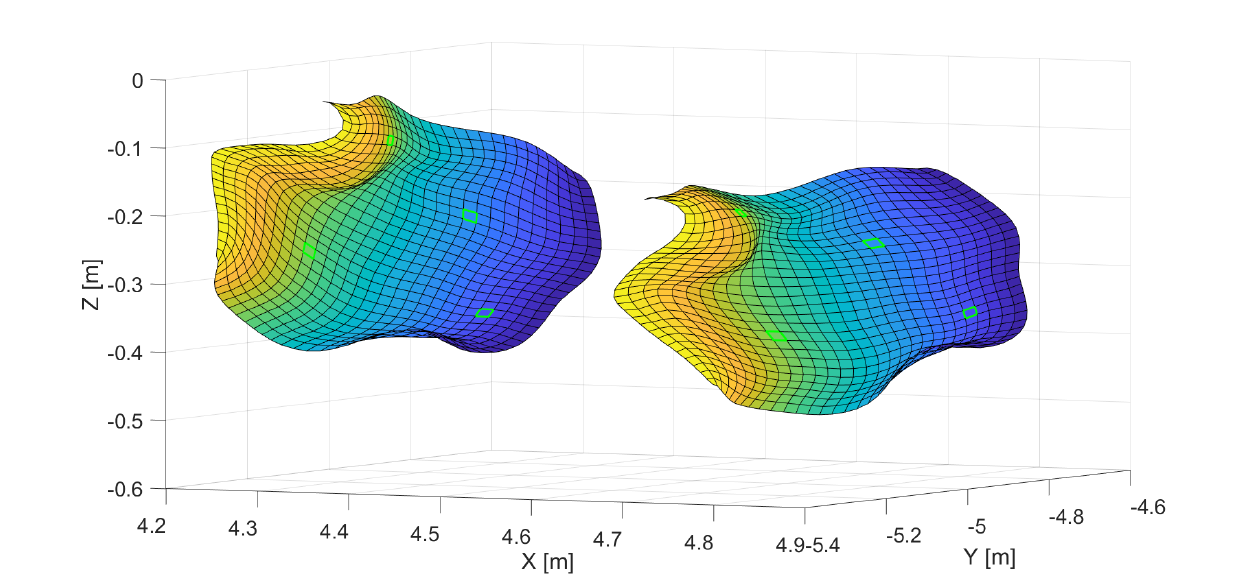
Figure 1. Rigid body movement of a B-spline surface (left surface: epoch 1, right surface: epoch 2): surface parameters define corresponding